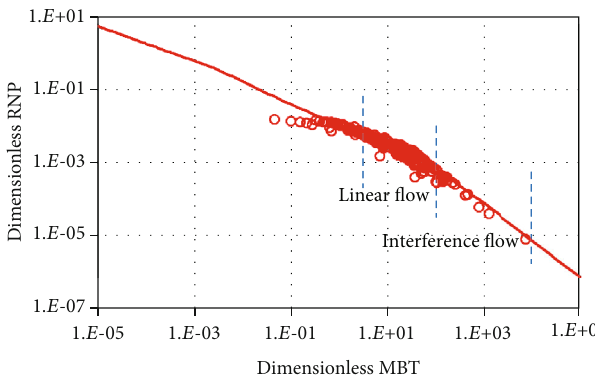
Linear flow Interference flow